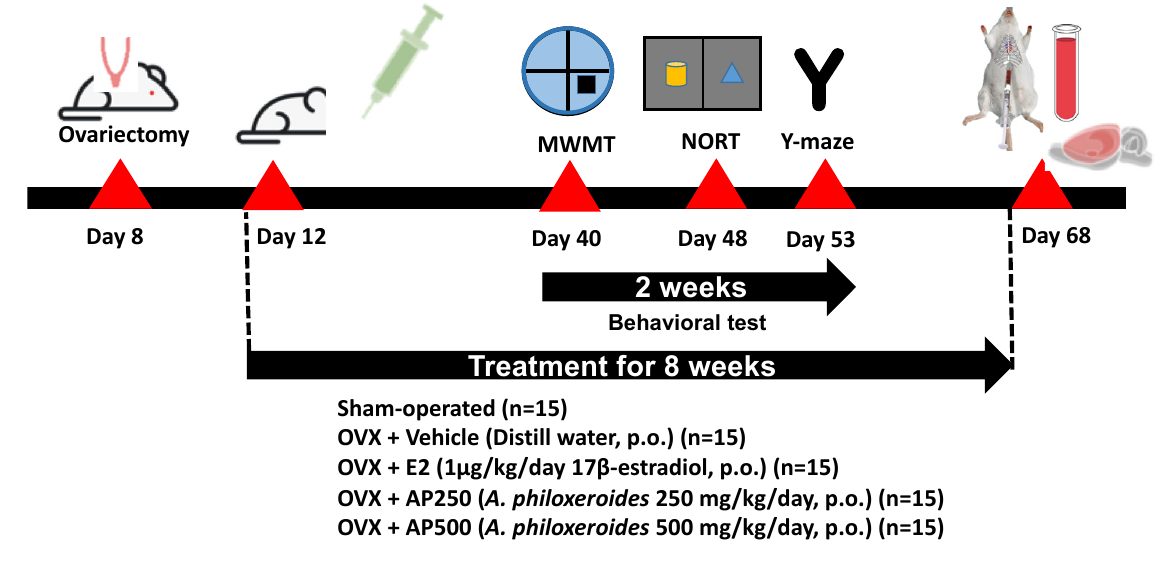
Figure 10. A schematic presentation of animal experimental design.